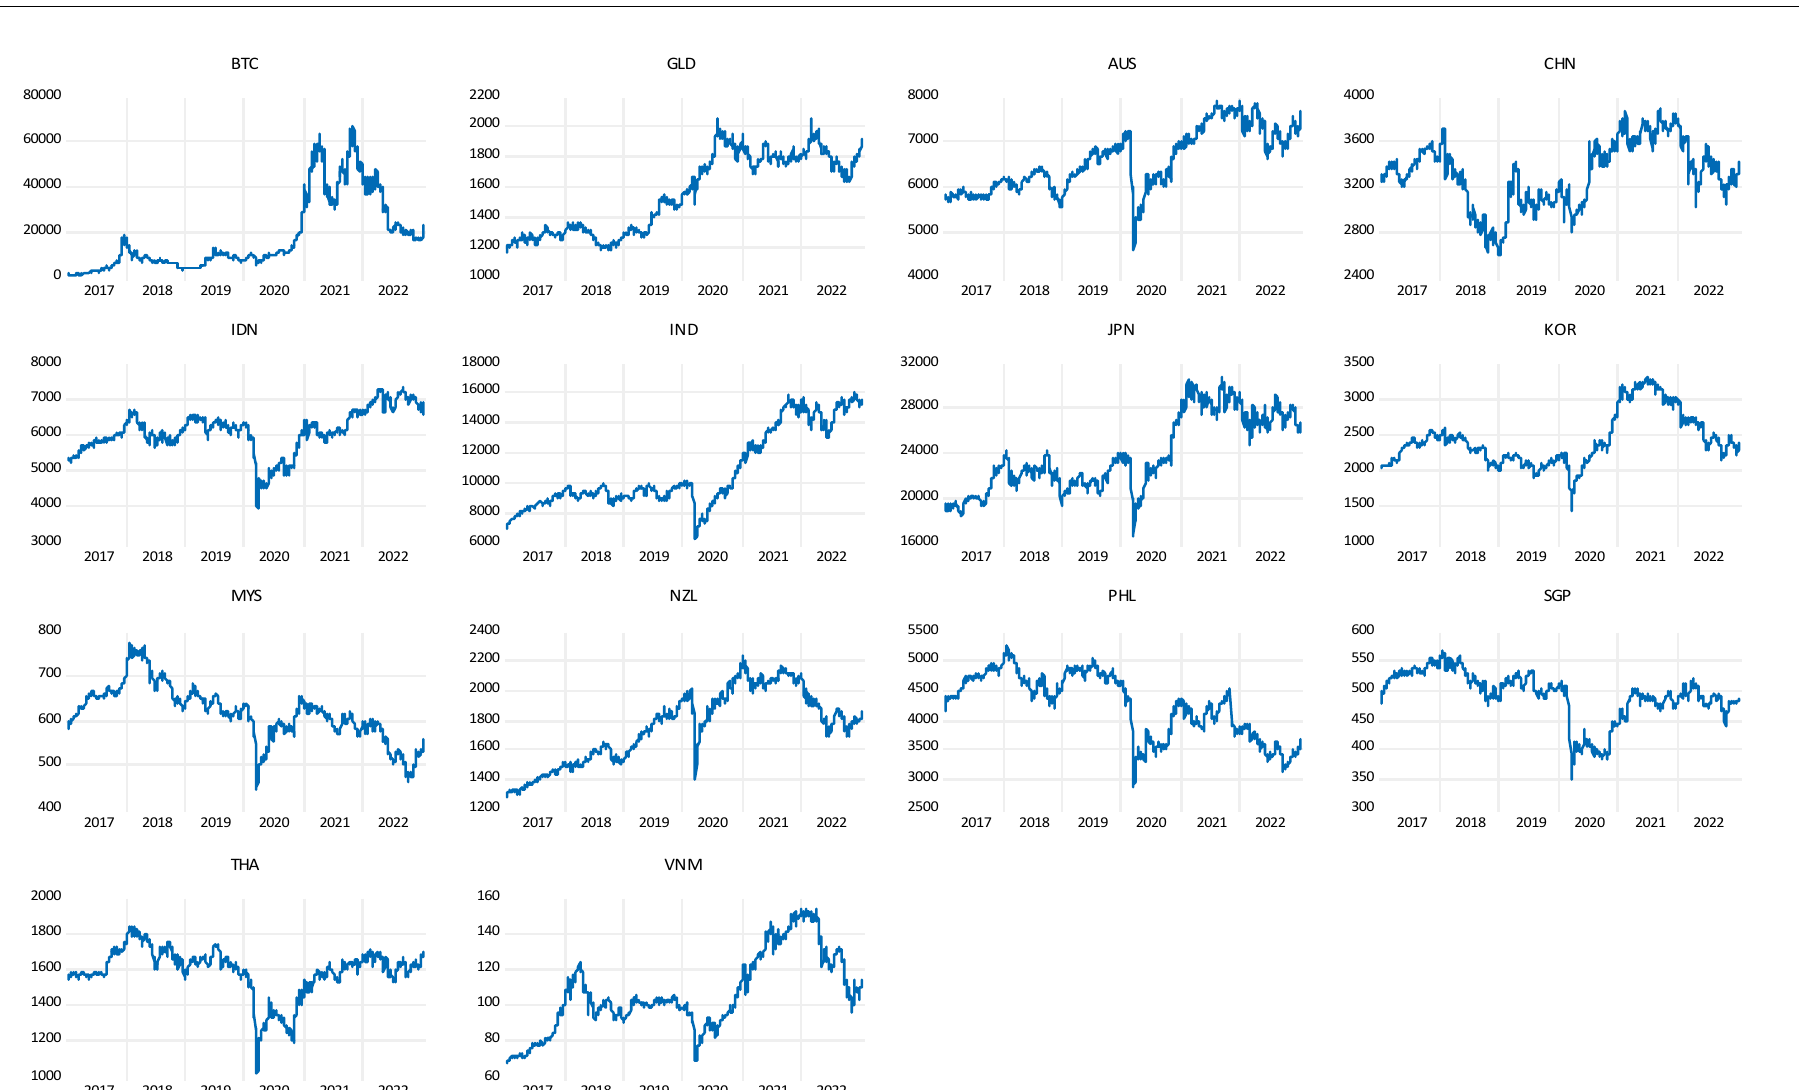
Figure 2. Prices dynamics of Bitcoin, gold, and ASEAN+6 stock indices.